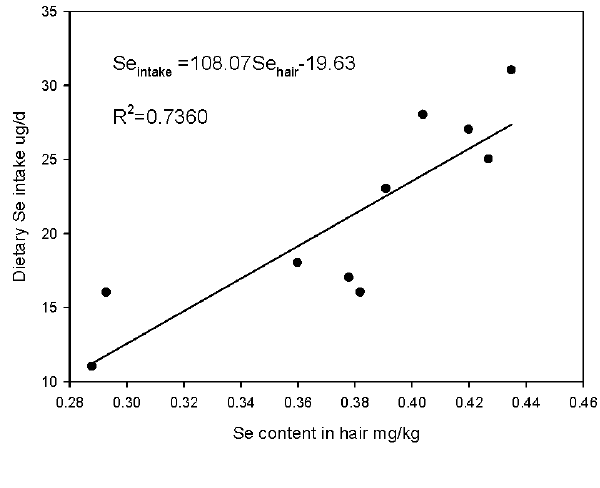
Figure 4. The relationship between daily Se intake and hair Se content in different districts ( n =